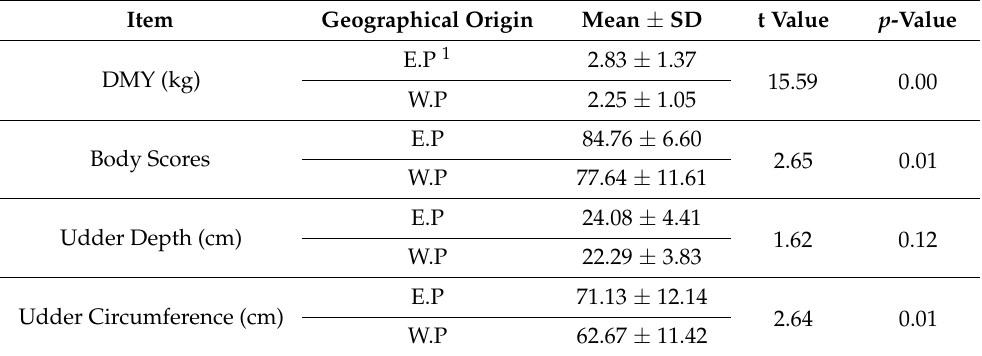
Table 3. Daily milk yields (DMY), body scores, and morphometric records of Western and Eastern Pakistani